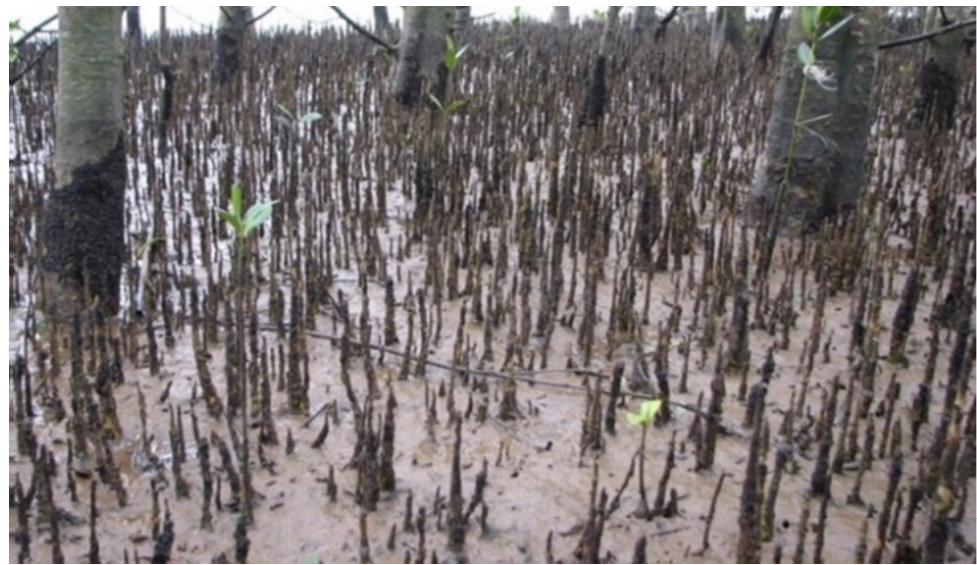
Figure 10. Pneumatophores of the mangrove tree Sonneratia apetala Buch. Ham. From Zhang et al. [103]. Creative Attribution